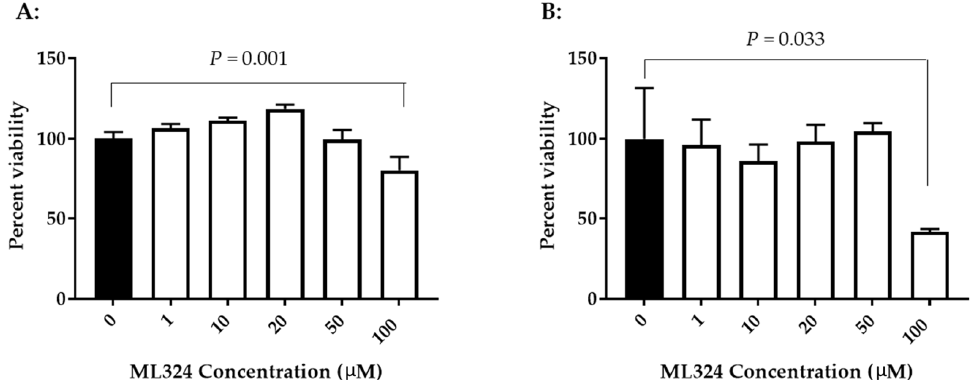
Figure 2. The cytotoxicity of ML324 in vitro. KF-1 cells ( A ) or CCB cells ( B ) were incubated with the indicated concentration of ML324 for 24 h. The treatment was then removed, and the cells were washed once with PBS and further incubated for 24 h in tissue culture media (DMEM) with 5% serum and antibiotics as described in the materials and methods. Cell viability was evaluated with the XTT cell viability kit III and expressed as a percentage of the mock-treated control ( n = 3). A significant statistical difference between the mock-treated control (0) and 100 µ M ML324 is marked above the line with a Bonferroni-corrected p -value calculated using a two-way ANOVA. The solid black column represents the mock-treated control. The open column represents the ML324 treat- ments.